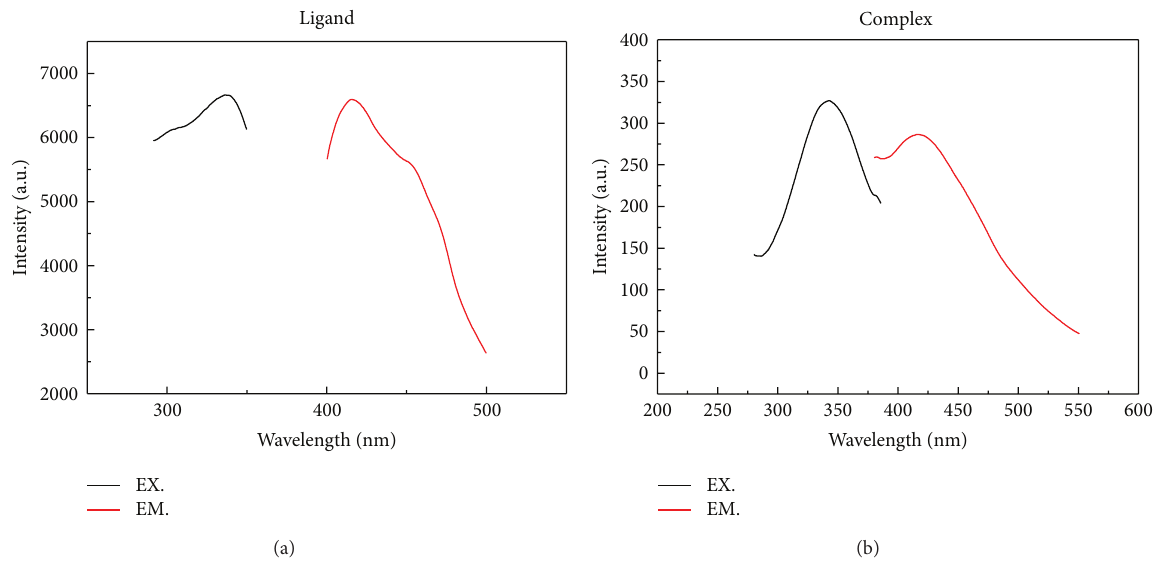
Figure 7: Photoluminescence emission spectra of the ligand and the